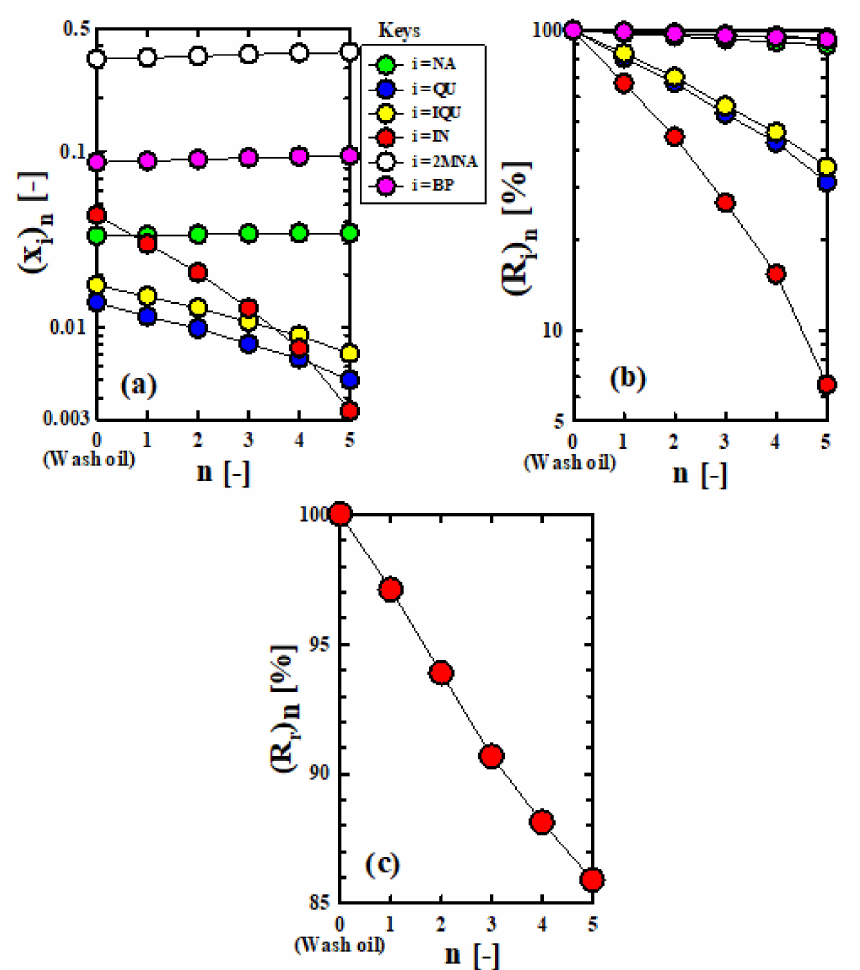
Figure 5. Changes in ( a ) (x i ) n , ( b ) (R i ) n , and ( c ) (R) n according to number of equilibrium extractions (n). Experimental conditions: y w,0 = 0.05, S 1 /R 0 = 1, T = 303 K, t = 72